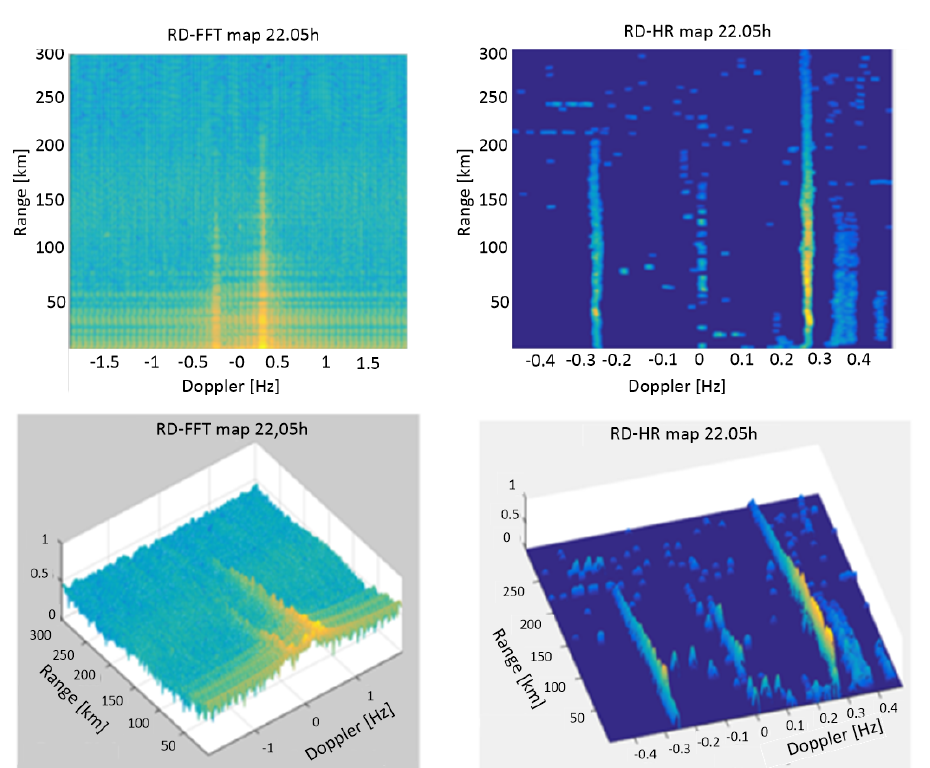
Figure 15. The comparison of RD-FFT map ( left ) and RD-HR map obtained by the proposed algorithm ( right